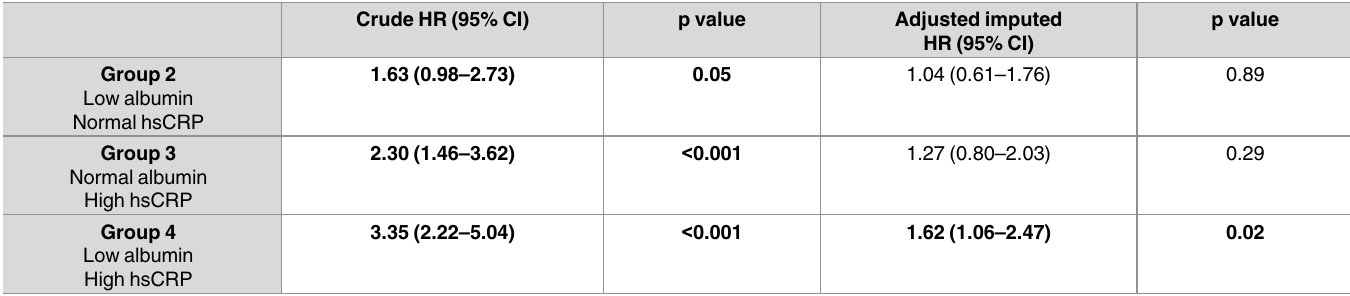
Table 3. All-cause mortality risk associated with low S-Alb < 35 g/L and high hsCRP (cid:21) 3 mg/L (Group 4) during 60 months of